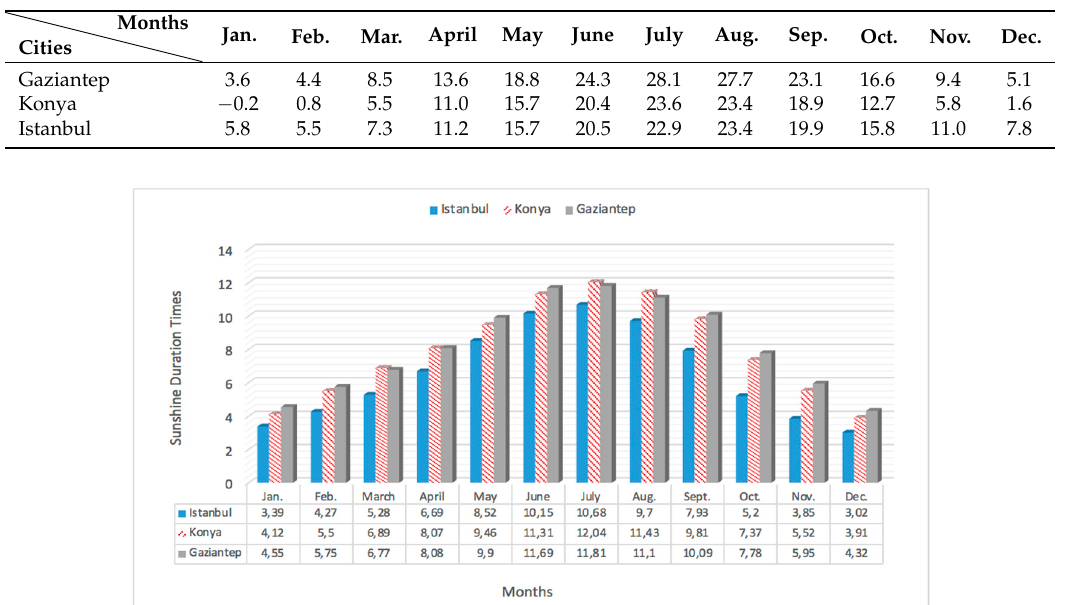
Table 4. Monthly variation in temperature in three cities between 1930–2018 [28].